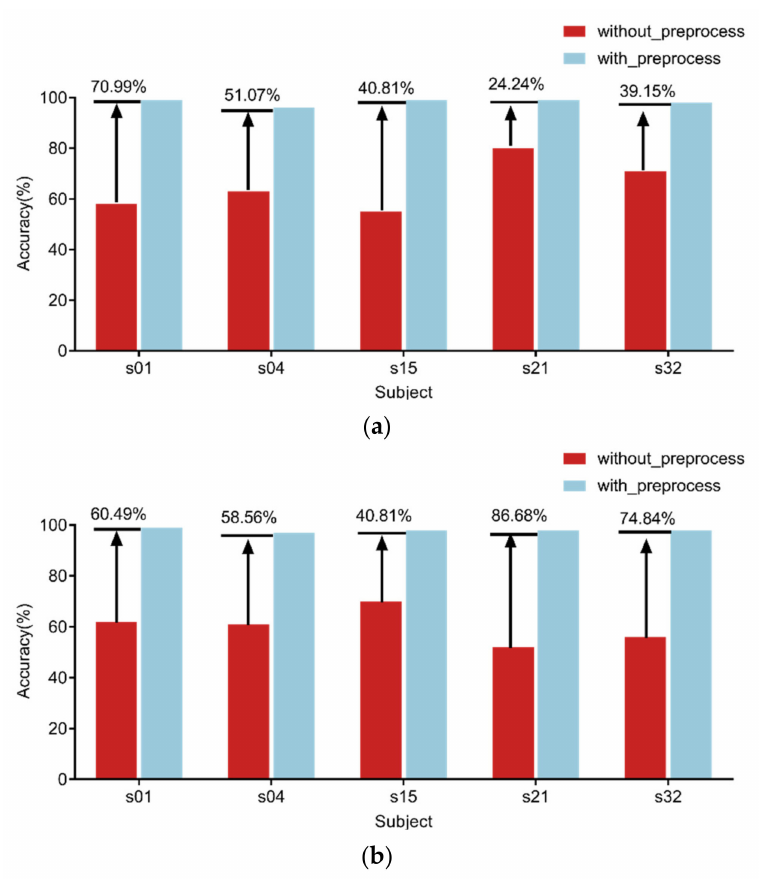
Figure 3. Comparison of accuracy on Arousal ( a ) and Valence ( b ) before and after baseline